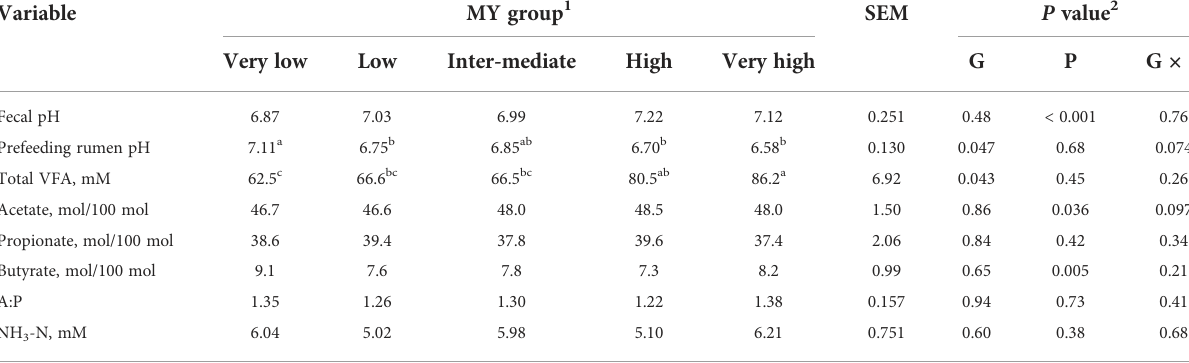
TABLE 5 Fecal pH and rumen fermentation variables of heifers by methane yield (MY) group.